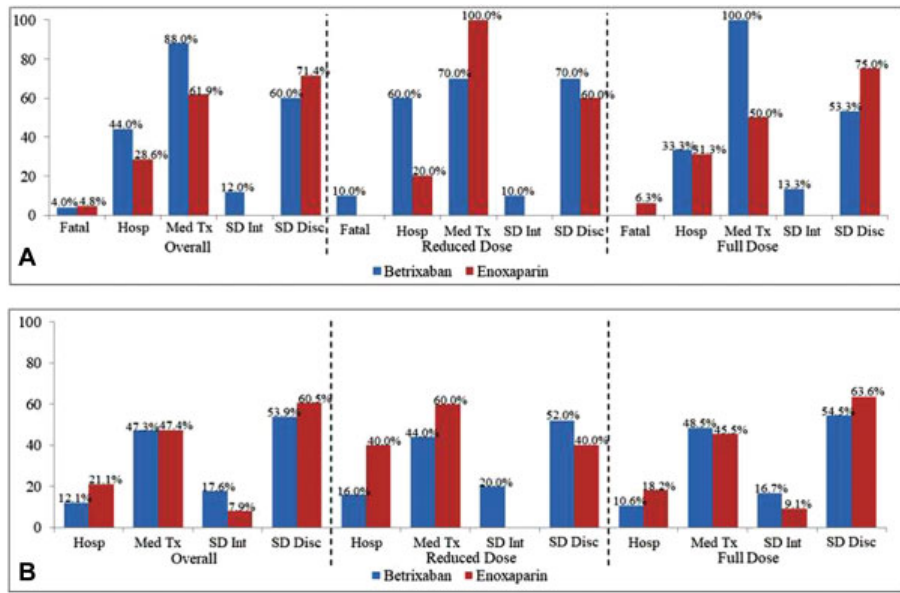
Fig. 3 Clinical outcomes of major bleeds ( A ) and clinical outcomes of CRNM bleeds ( B ). Hosp, required or prolonged hospitalization; Med Tx, required medical treatment; SD Int, study drug interruption; SD Disc, study drug